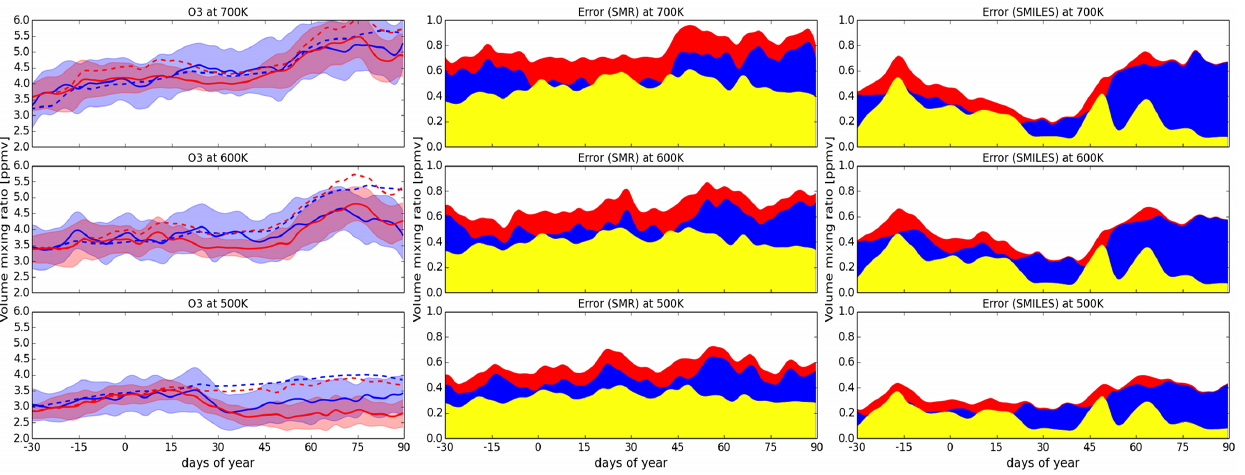
Figure 9. (Left panels) Same as Fig. 5 but for ozone from SMR (blue) and SMILES (red). (Middle panels) Same as Fig. 6 but for ozone from Fig. 9: (Left panels) Same as figure 5 but for ozone from SMR (blue) and SMILES (red). (Middle SMR. (Right panels) Same as Fig. 6 but for ozone from panels) Same as figure 6 but for ozone from SMR. (Right panels) Same as figure 6 but for ozone from SMILES.